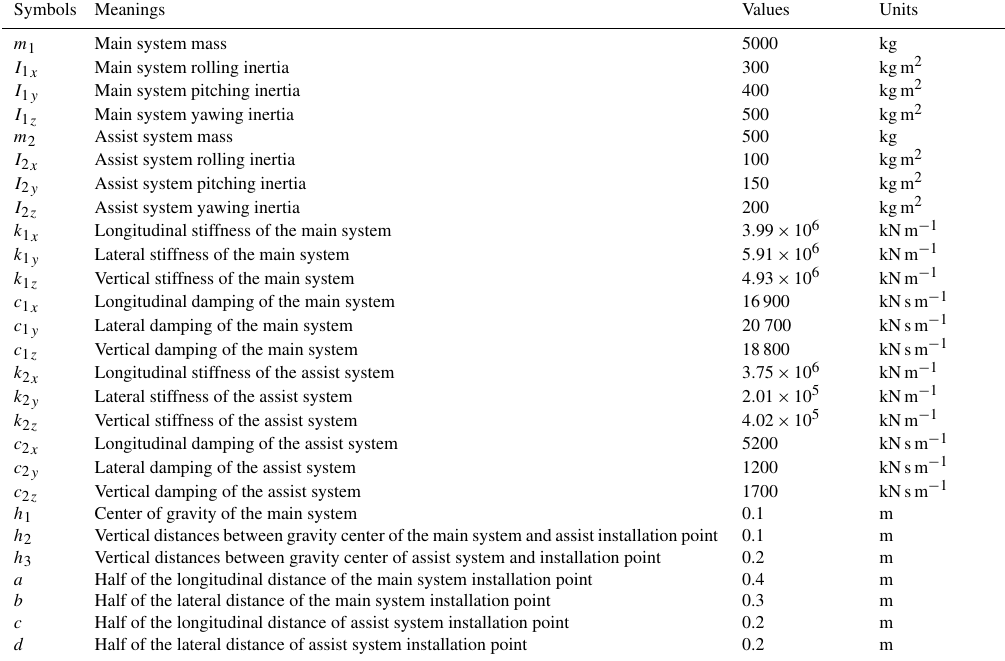
Table A1. Parameters for the multi-DOF DVA. Symbols Meanings